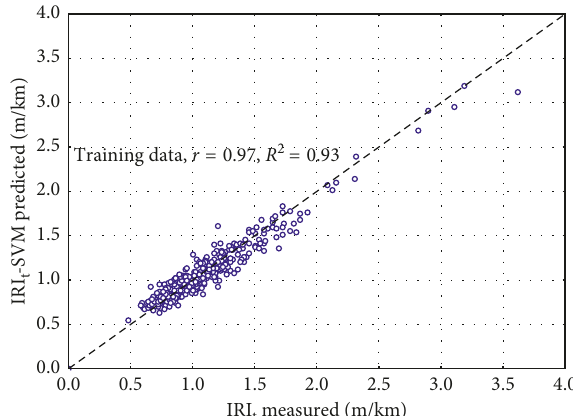
t using the SVM model: